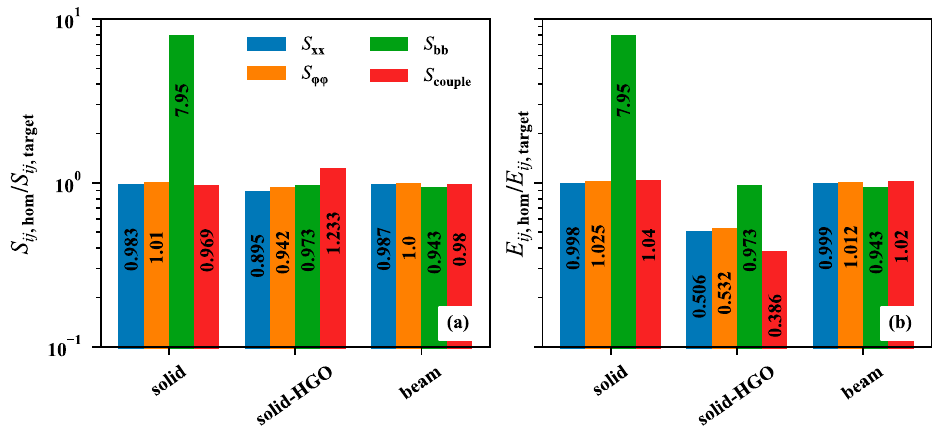
Figure 9. The three anisotropic efficient cable-modeling approaches with their relative stiffness values in terms of ( a ) S ij and ( b ) E ij . Note that the parameters of the efficient models were calculated or fit to reach S ij .